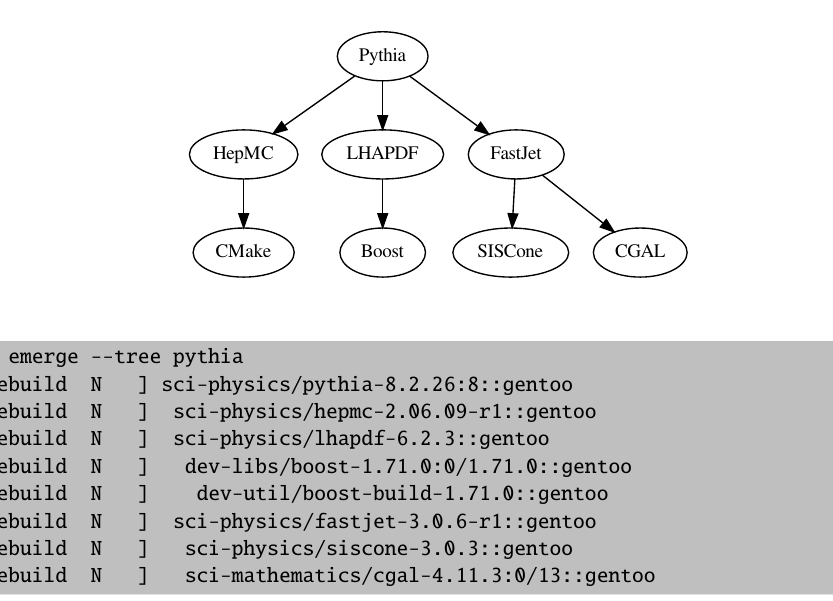
Figure 1. Example dependency graph of Pythia physics event generator and demonstration of installa- tion by emerge , the Gentoo portage user interface command. Recursive dependencies are automatically drawn